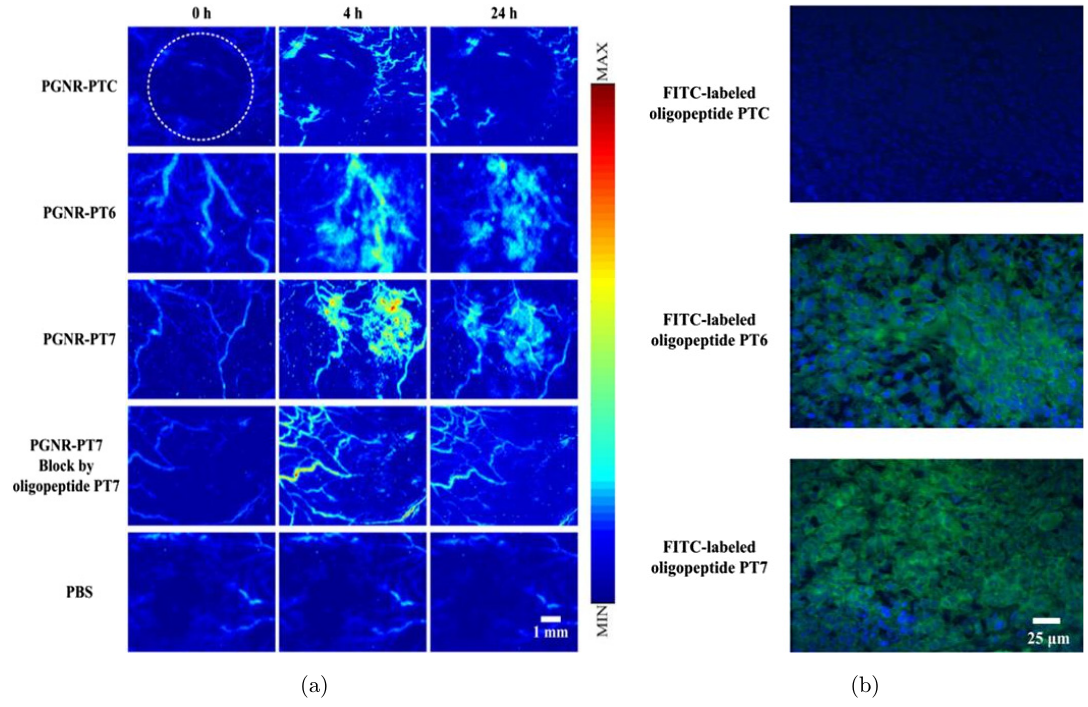
Fig. 3. (a) Sequential PA MIP frames of the tumor site before and after intravenous injection of PGNR-PTC, PGNR-PT6, PGNR- PT7, with pre-blocking and PBS at pre-administration (0 h), 4 h and 24 h after injection. (b) Representative °uorescence images of UMR-106 OS tissue sections stained with FITC-labeled PTC, PT6 or PT7 (100